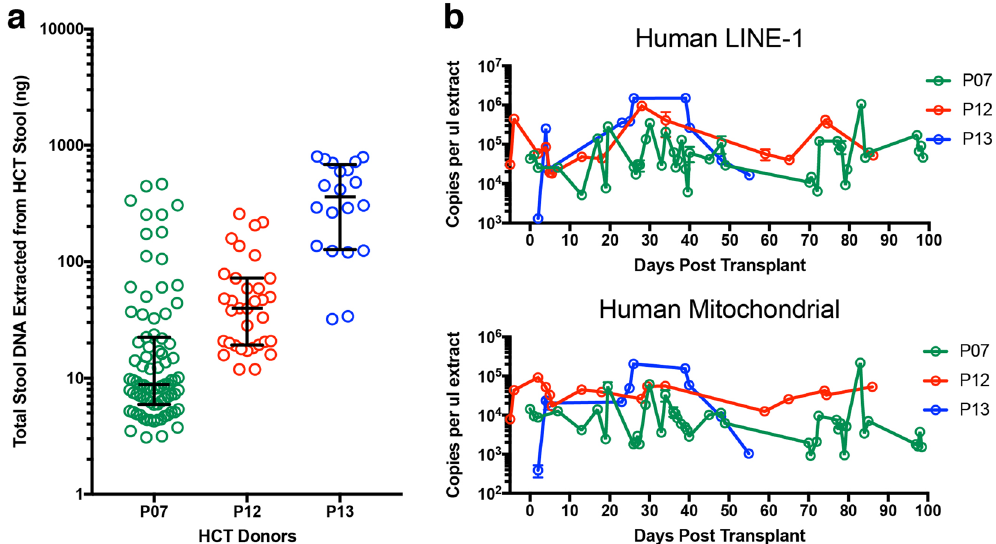
Figure 7. Quantification of host DNA from human patient stools using ddPCR. ( a ) Total DNA recovered from two side-by-side DNA isolations from 69 stool samples from three hospitalised patients (P07, P12, and P13) undergoing allogeneic HCT. Each circle represent DNA recovered from a single DNA extraction. The horizontal lines represent the median and interquartile range. ( b,c ) Human DNA quantified using human LINE-1 (60-bp amplicon) and mitochondrial (83-bp amplicon in the ND5 gene) assays. Error bars in ( c–f ) represent range of copy numbers from single ddPCR reactions on the duplicate DNA extraction. For some points, the error bars would be shorter than the height of the symbol. In these cases, the error bars were not